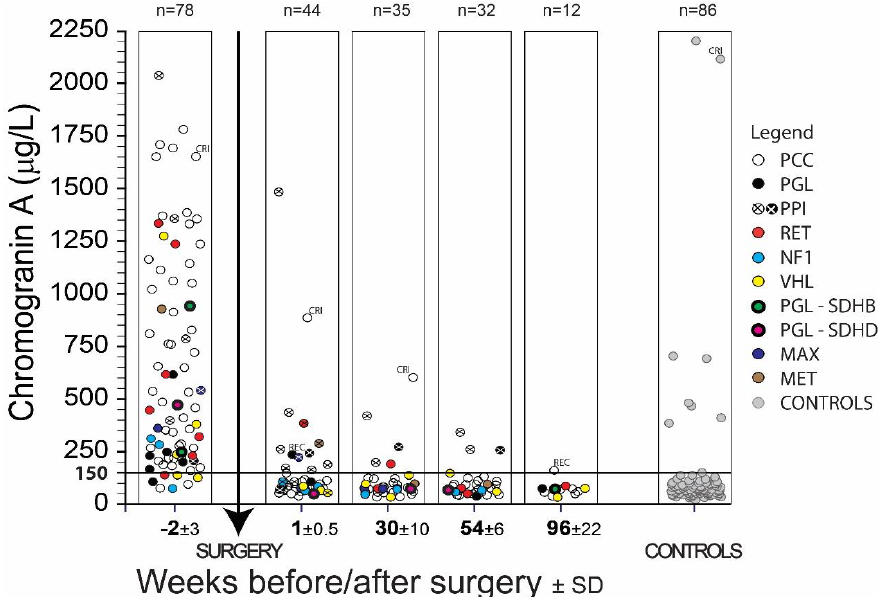
Figure 1. The results of chromogranin A (CGA) determination in PPGL patients before and after surgery. Symbols indicate the type of PPGL and found mutations in genes RET ; NF1 ; VHL ; SDHB ; SDHD ; MAX ; MET . The meaning of abbreviations is pheochromocytoma (PCC); paraganglioma (PGL); patients treated with proton pump inhibitors (PPI); patients with chronic renal insu ffi ciency (CRI); patients with a recurrence of the disease